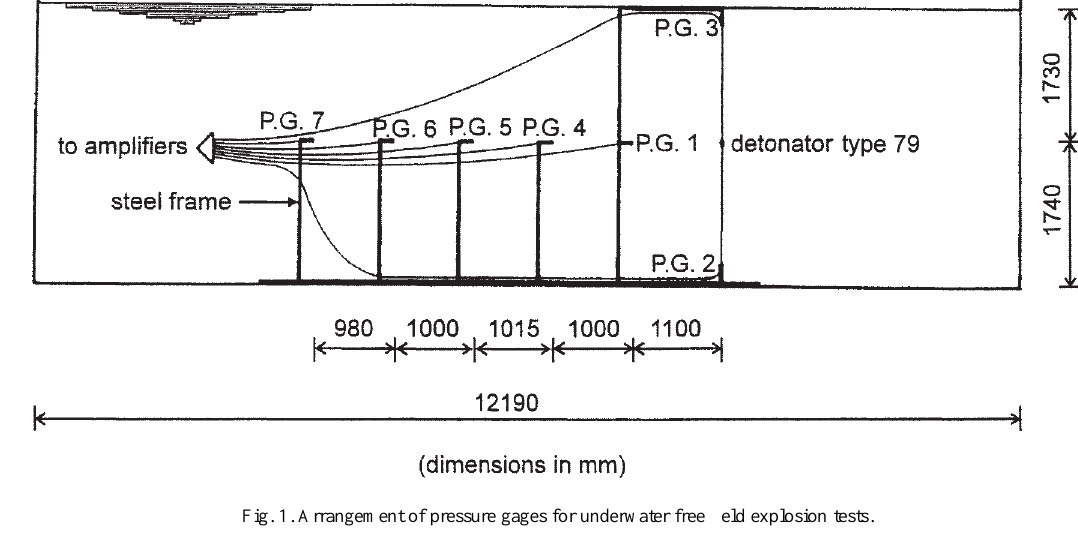
Fig. 1. Arrangement of pressure gages for underwater free field explosion tests.